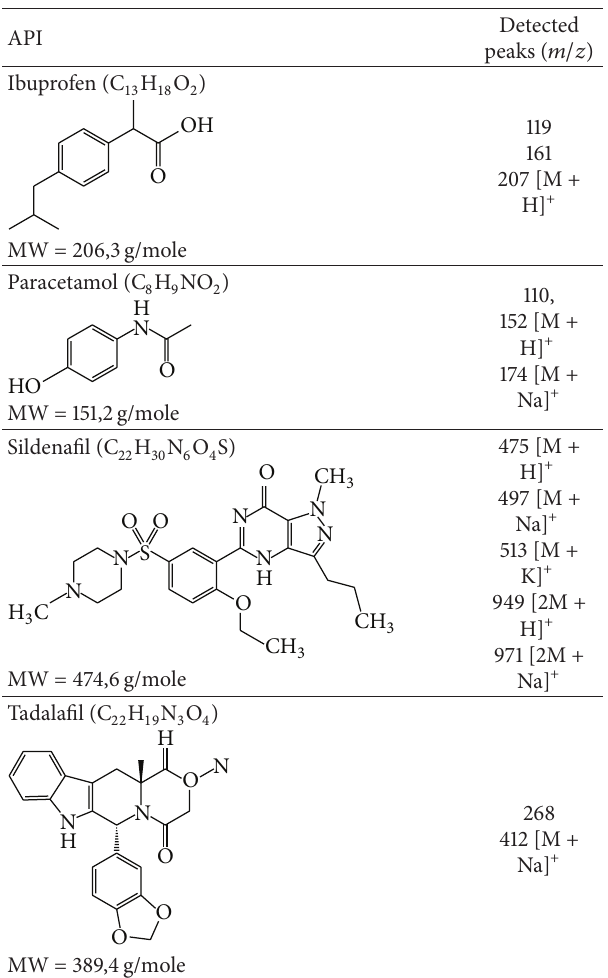
Table 1: APIs analyzed in this study, molecular formula, molecular weights, molecular structure, and detected 𝑚/𝑧 ions with proposed